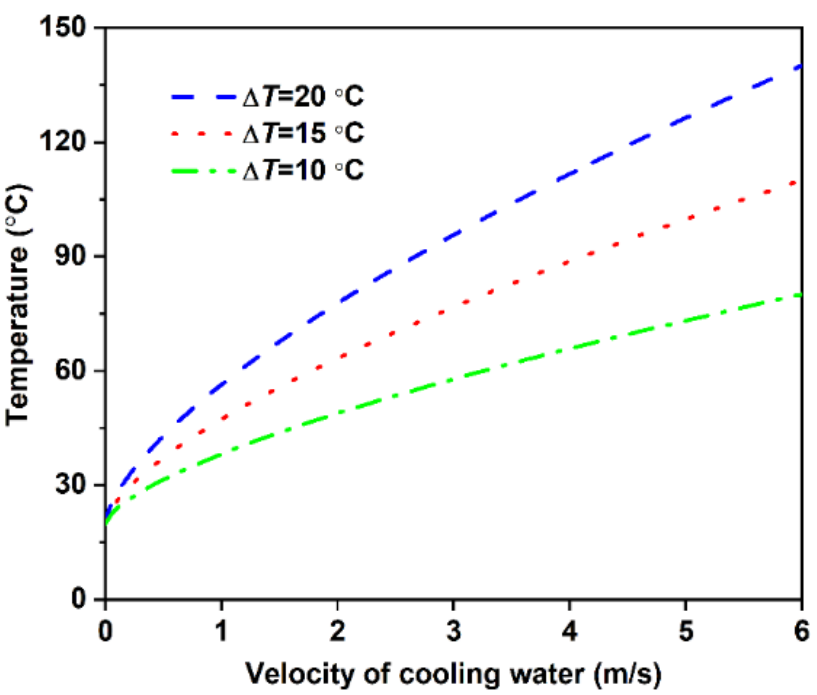
Figure 5. Roll temperature at the cooling water/roll interface as a function of velocity of cooling water.